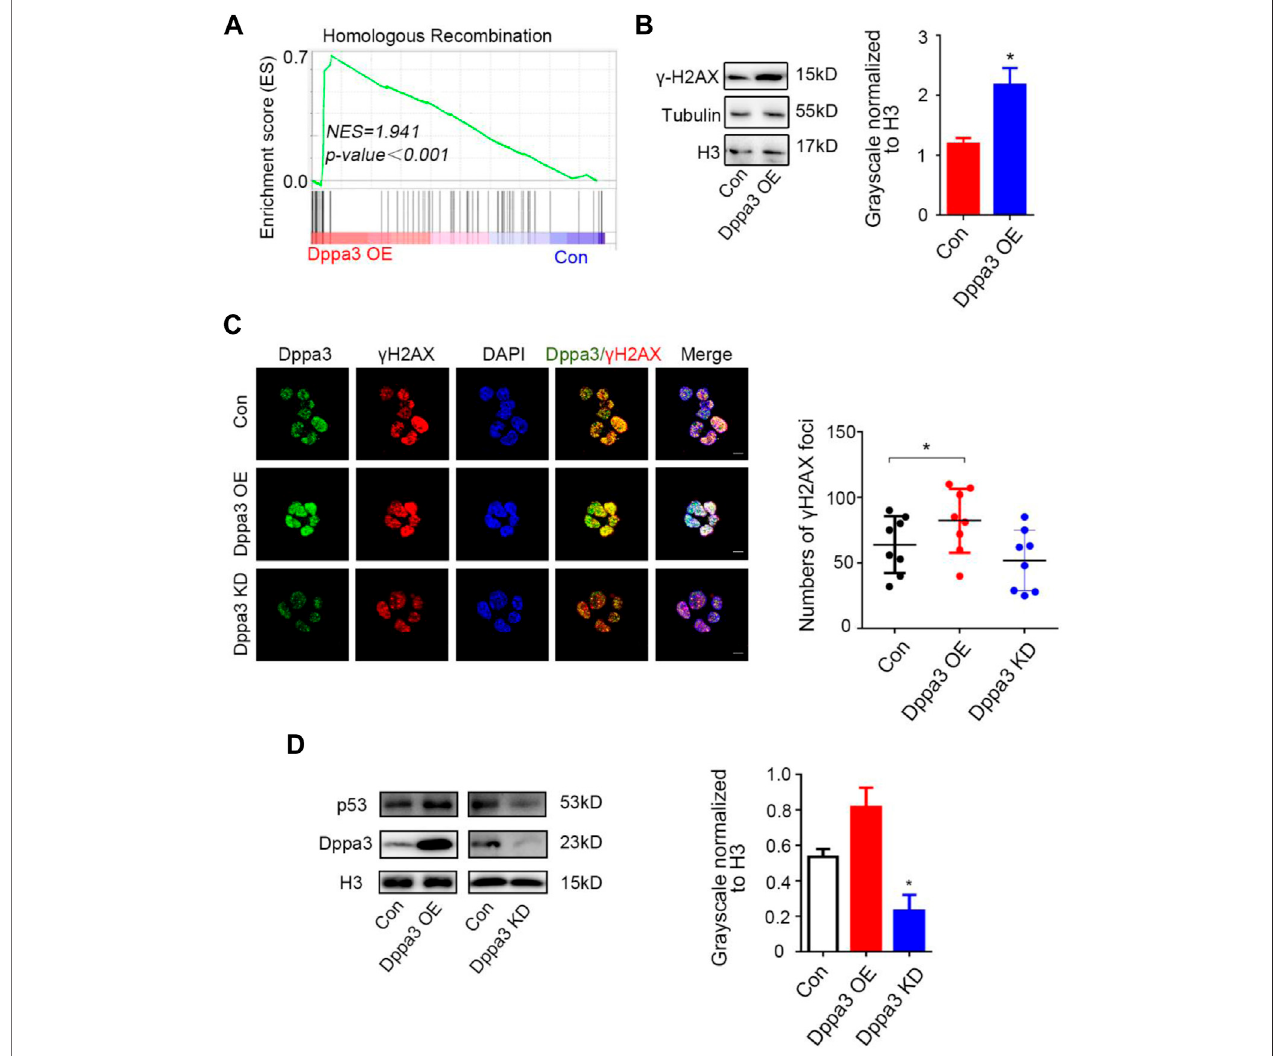
FIGURE 4 | Dppa3 induces DNA damage response in ESCs. (A) Gene set enrichment analysis (GSEA) indicating that upregulated genes in Dppa3 OE ESCs are highly enriched inDNArecombination andrepairpathway. (B) Westernblotanalysisofthelevelof γ H2AXin Dppa3 OEand controlESCs. Right:Quanti fi cationofrelative γ H2AXproteinlevelsnormalizedtoH3byImageJsoftware( n =3;* p < 0.05). (C) Immuno fl uorescenceanalysisof γ H2AXbystainingforDppa3(green), γ H2AX(red),and DAPI(blue)in Dppa3 OE, Dppa3 KD,and controlESCs.Scalebar =10 μ m.Rightpanel:Statistics ofthenumberof γ H2AXfociineach cell.Thedataarepresented asmean±SEM( n =4;* p < 0.05;eachdotcorrespondstothenumbersof γ H2AXfociineachcellinonereplicateexperiment). (D) Westernblotanalysisofp53in Dppa3 OE, Dppa3 KD, and control ESCs. Right: Quanti fi cation of relative p53 protein levels normalized to H3 by ImageJ software ( n = 3; * p < 0.05).